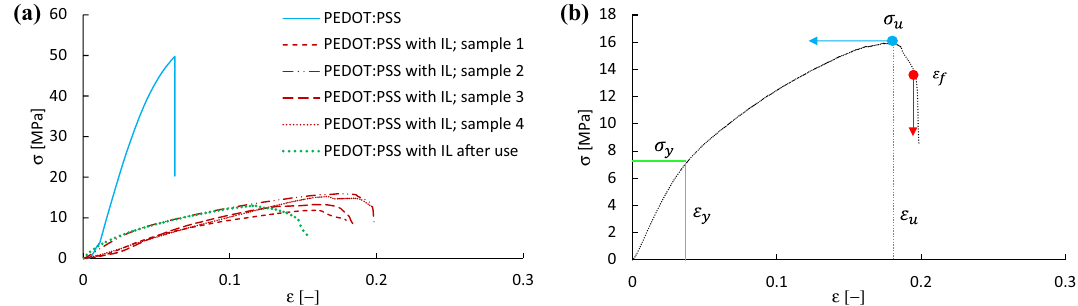
Figure 5. ( a ) Stress–strain curves for the PEDOT:PSS films with and without IL doping and a measurement of an IL-doped PEDOT:PSS after its use as a cathode during a battery discharge. ( b ) Schematic representation of the stress and strain definitions for Table